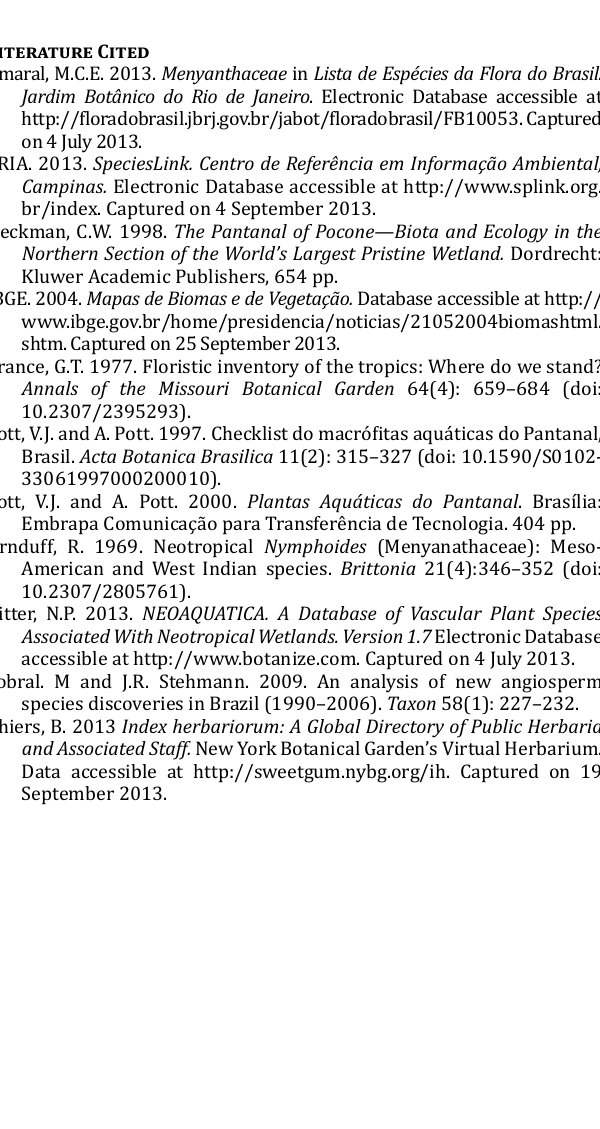
Kuntze (Menyanthaceae) in